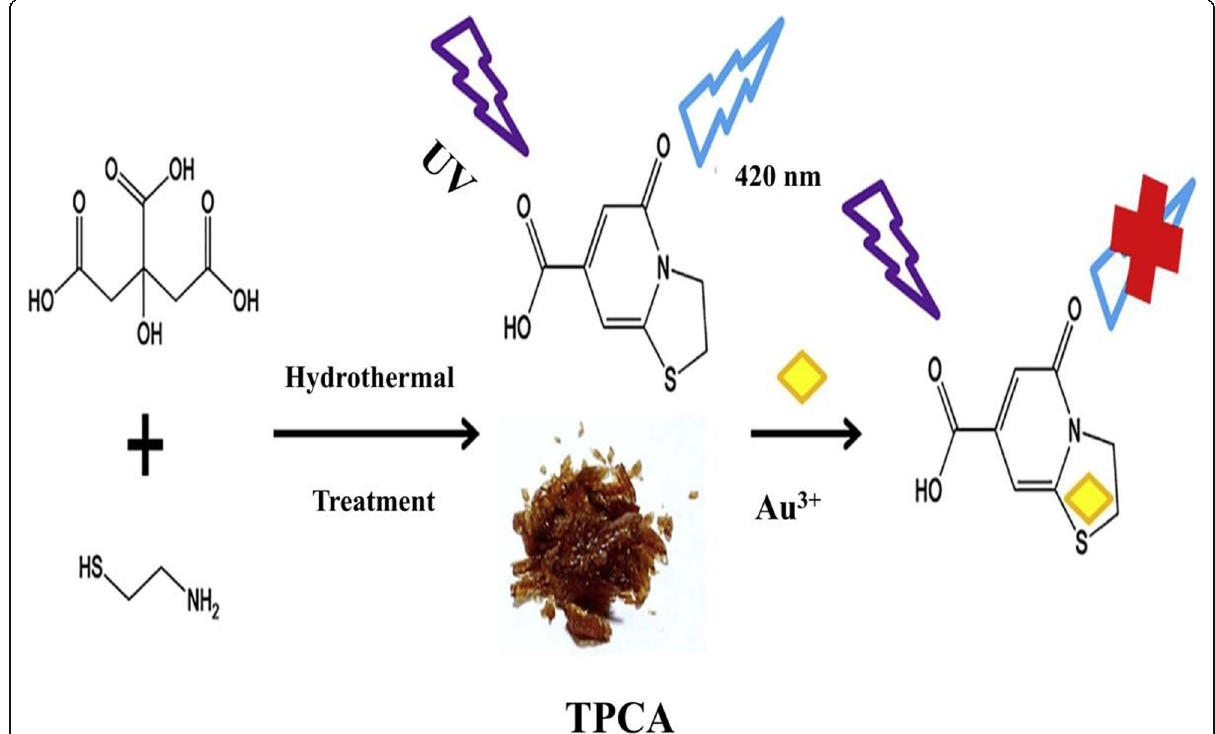
Fig. 7 Schematic representation of TPCA synthesis using CA and cysteamine through hydrothermal route for detection of Au 3+ [ “ Reprinted (adapted) with permission from [30]. Copyright 2019 Elsevier. ”